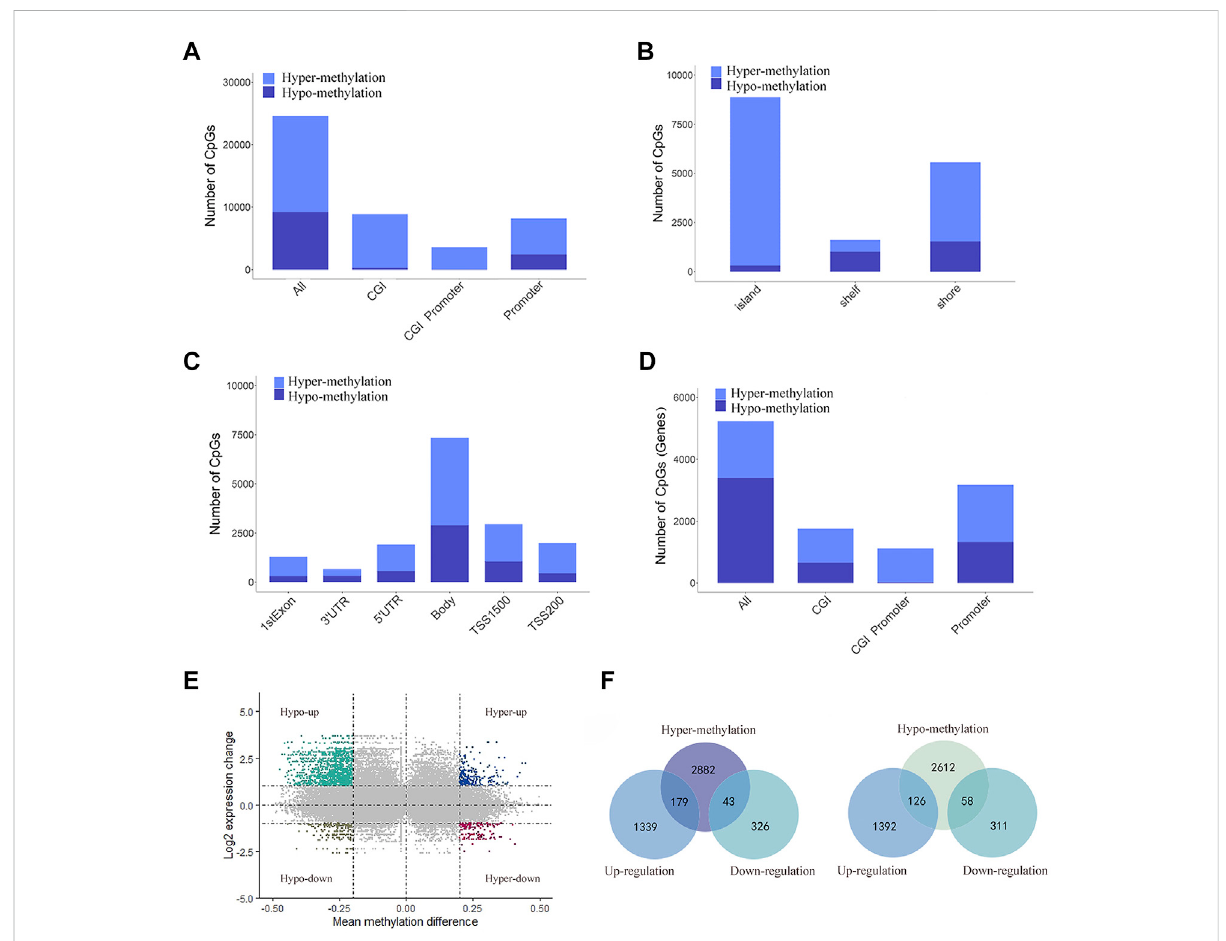
FIGURE 2 Distribution of DMSs and obtain mrDEGs of LUAD. (A) Distribution of DMSs across various genomic regions, including CpG islands (CGI), promoters, CGI promoter, and the whole genome (all). (B) Distribution of DMSs in various areas related to CGI distance, including CpG shelves, CpG shores and CpG islands. (C) Distribution of DMSs in gene location, including 3 ′ UTRs, gene bodies, fi rst exons, 5 ′ UTRs, TSS200 and TSS1500. (D) Distribution of DMGs across various genomic regions. (E) Scatter plot shows mean methylation difference versus log2 expression change, and eachpoint representsapairofmethylationsiteandgene. (F) VenndiagramsshowstheintersectionbetweenDEGs andhypermethylatedgenes(left) and between DEGs and hypomethylated genes